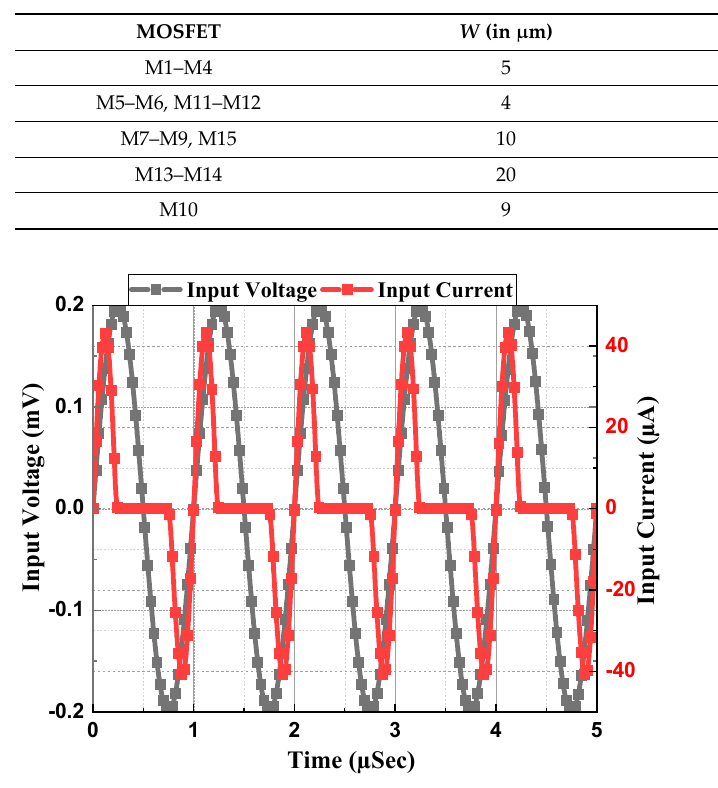
Figure 4. Transient Analysis at 1 MHz with 15 pF Capacitor.